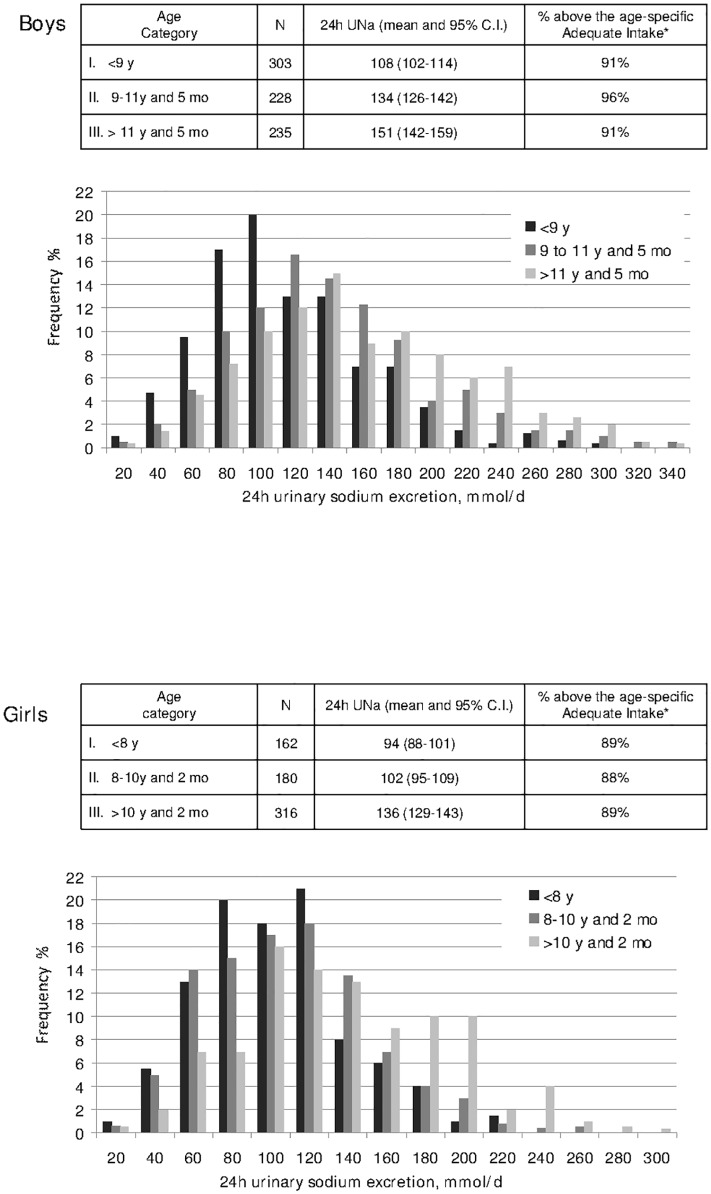
Gender-specific frequency distribution of 24-hour urinary sodium excretion in boys (A) and girls (B) (data from 10 Italian regions, age 6–18 years, MINISAL-GIRCSI Program).The insets in the figures report the mean values of electrolyte excretion by development stage and denote the percentage of individuals complying with the respective adequate intakes as established by the Italian Society for Human Nutrition and the Institute for Food Research and Nutrition (ref. 18). *Data based on the assumption that 24h urinary sodium excretion provides an estimate of daily sodium intake.